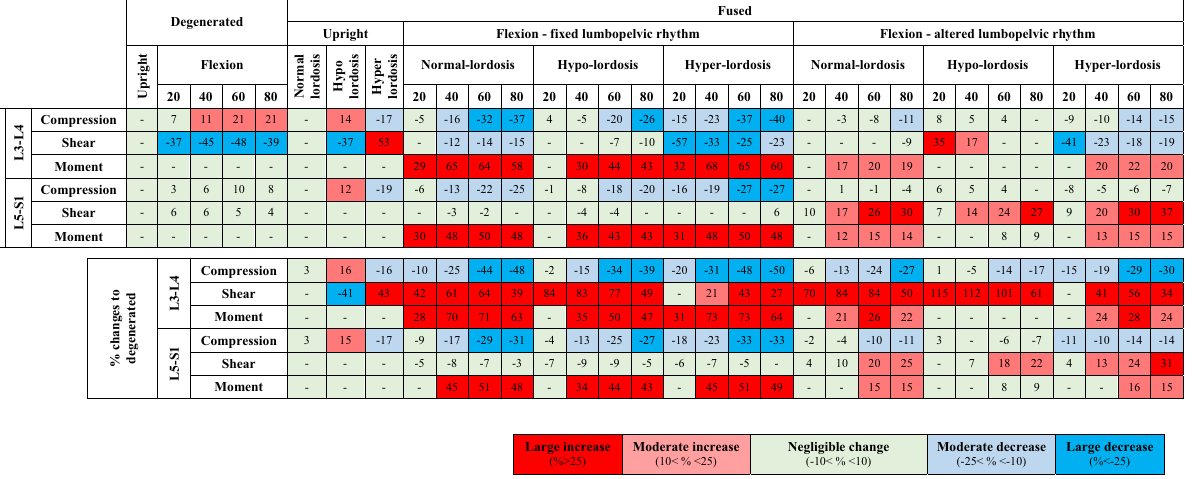
(though by < 16%) at both adjacent segments (Table 1). Shear force decreased at the upper segment by up to 41% (Table 1). In contrast, the hyper-lordosis condition decreased external flexion moments, all muscle forces (Table 2) and consequently adjacent segment compression forces by up to 19% as compared to preoperative states (Table 1). In this configuration, the shear force increased at the upper segment by up to 53%. Irrespective of the hypo or hyper-lordosis postures, passive moments at both adjacent segments and shear force at the lower segment were only slightly affected (< 10%) when compared to those in both preoperative states (Table 1). More- over, the postoperative normal-lordosis configuration yielded results almost the same as those in the preopera- tive intact and degenerated states with alterations in all cases < 10% (Table 1). Muscle injuries had slight effects in local muscle forces, compression forces, shear forces and passive moments at adjacent segments (all < 10%) (Tables 1,2). Flexed postures. With the fixed postoperative LPR, larger flexion angles at the adjacent segments significantly increased their passive moments by up to 73% (Table 1 and Fig. 5). This reduced local muscle forces and adjacent segment compression loads when comparing to preoperative flexed states (Tables 1, 2). At the upper adjacent segment, shear forces generally decreased with respect to the intact state but significantly increased when com- pared to the degenerated state (Table 1). With the altered postoperative LPR compared to the fixed LPR, adjacent segment effects were generally less pronounced with the exception of the upper adjacent segment shear loads which increased by up to 115% when compared to the degenerated state (Table 1). The effect of muscle damages alone (with no postoperative alteration in kinematics) on adjacent segment kinetics was found < 3% in 80° trunk flexion task.